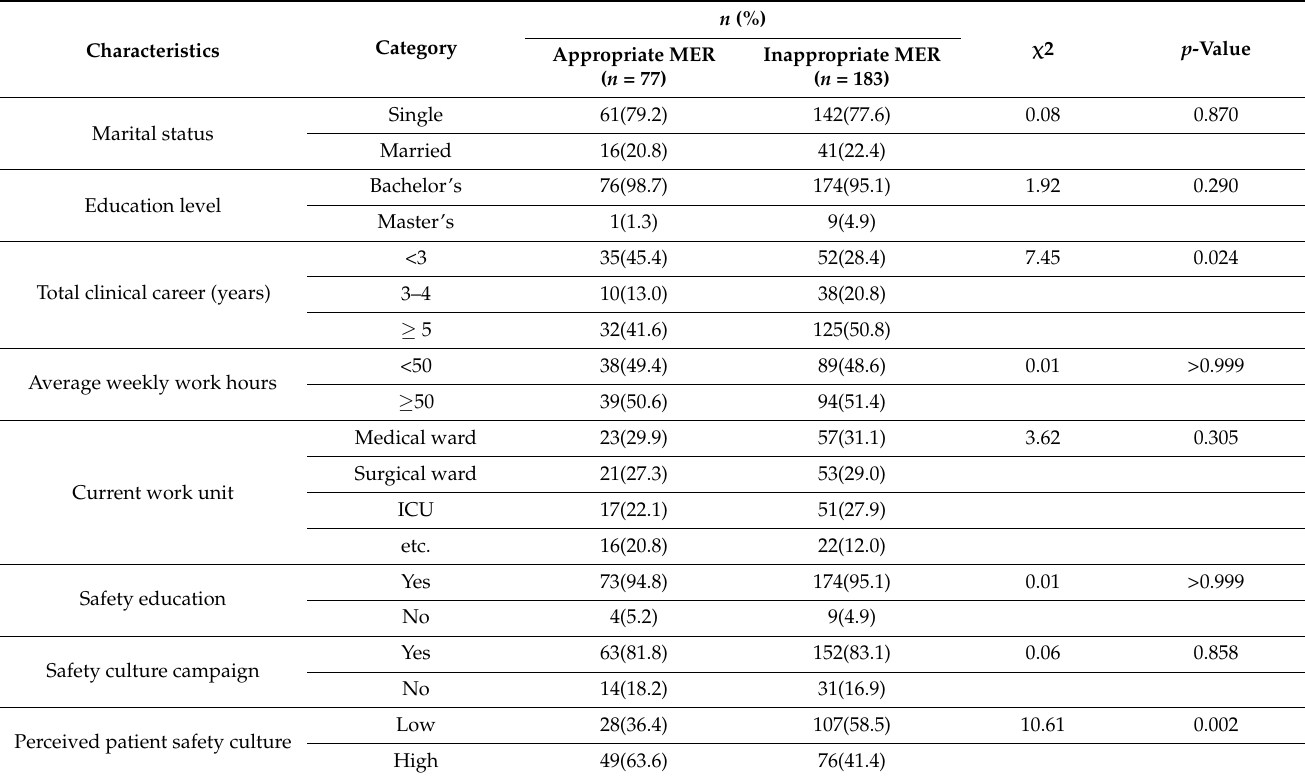
Table 3. Differences in medication error reporting according to the characteristics of early-career nurses ( n = 260).